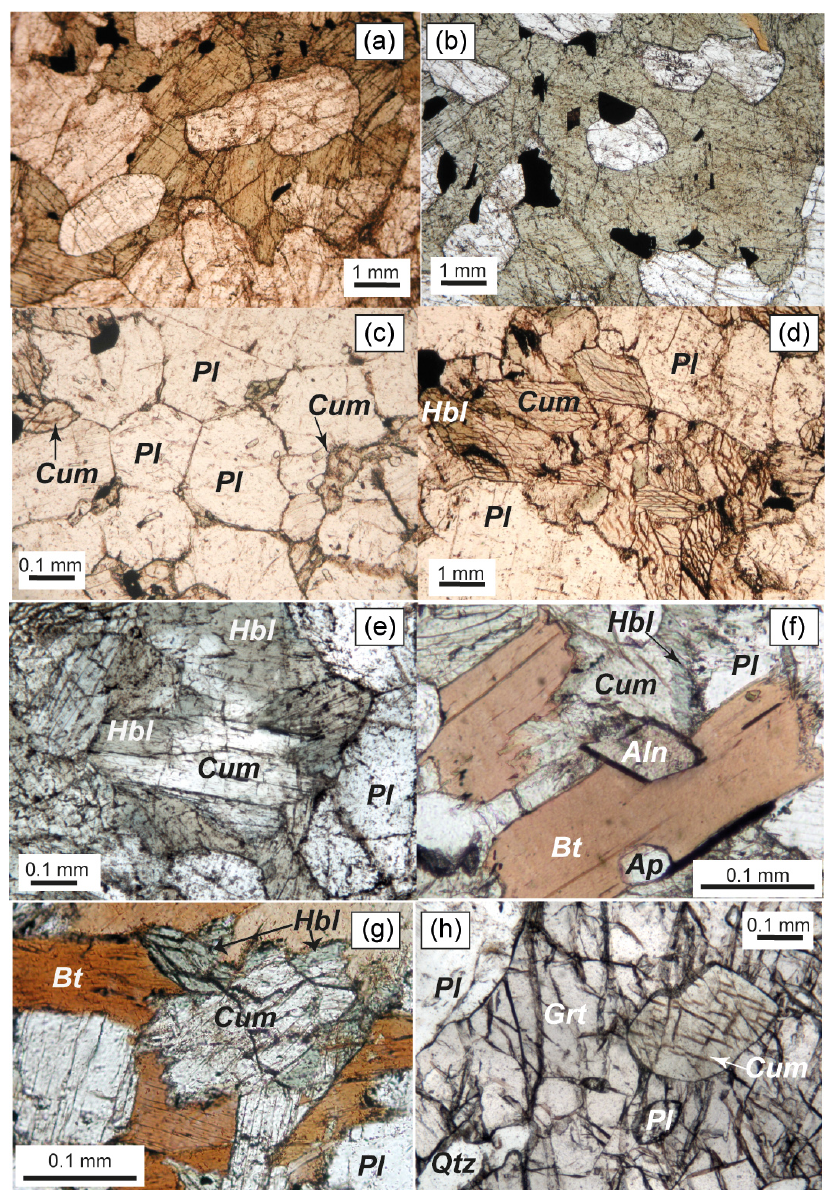
Figure 4. Thin-section photomicrographs of (a, b) poikilitic amphibole enclosing plagioclase grains (samples PN4 and PN3, respectively); (c) plagioclase showing 120 ◦ triple junctions (sample PN4); (d) aggregate of polygonal amphibole grains (sample PN2); (e) amphibole showing pale-brown (cummingtonite) core and green (hornblende) rim (sample PN4); (f) allanite associated with biotite and amphibole (sample PN1); (g) amphibole showing pale-brown (cummingtonite) core and green (hornblende) rim (sample SI-1); and (h) inclusions of plagioclase, quartz and cummingtonite in garnet (sample